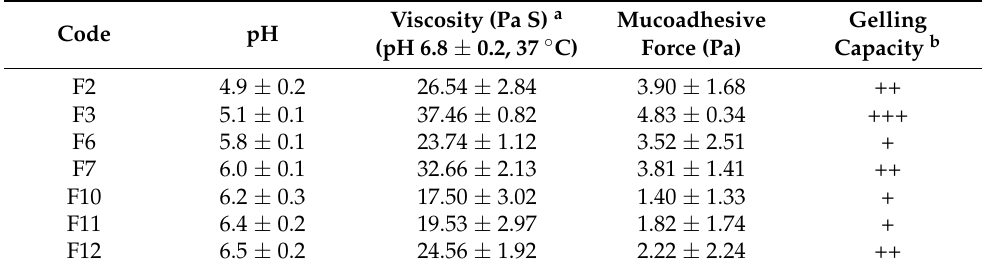
Table 1. pH, viscosity, mucoadhesive force and gelling capacity of the developed in situ gelling